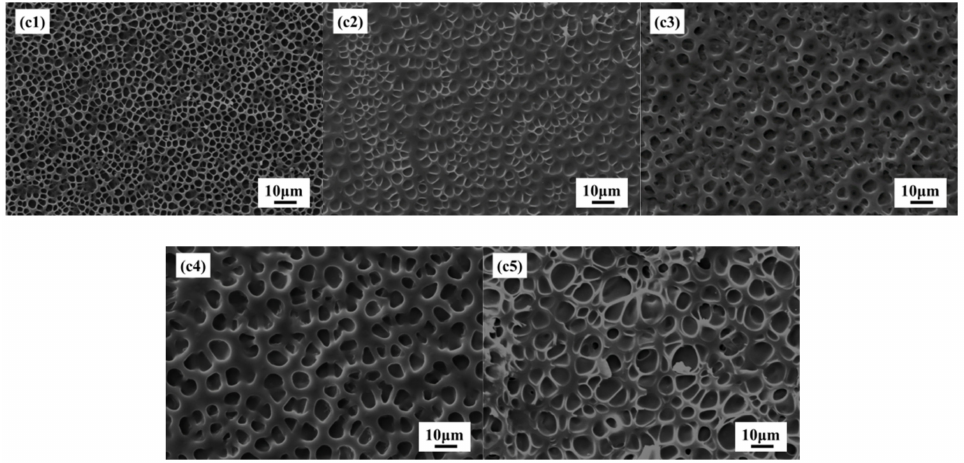
Figure 7. SEM images for ( c1 ) pure PDLC; ( c2 ) PDLC with 0.2% MgO; ( c3 ) PDLC with 0.4% MgO; ( c4 ) PDLC with 0.6% MgO; ( c5 ) PDLC with 0.8%